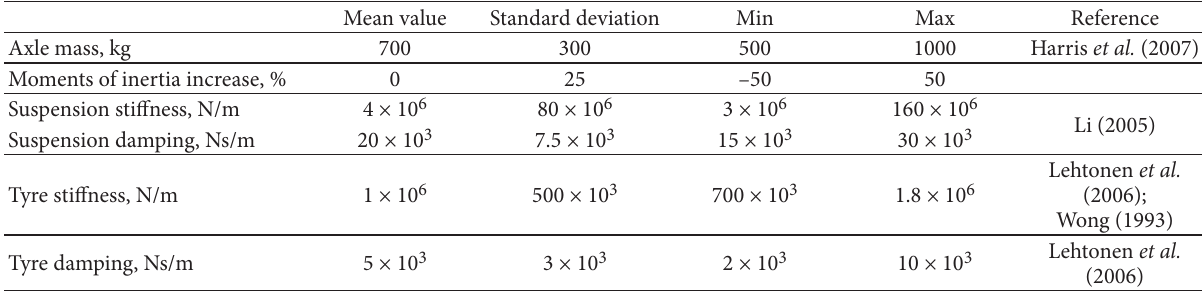
Table 3. Crane type vehicles parameters and